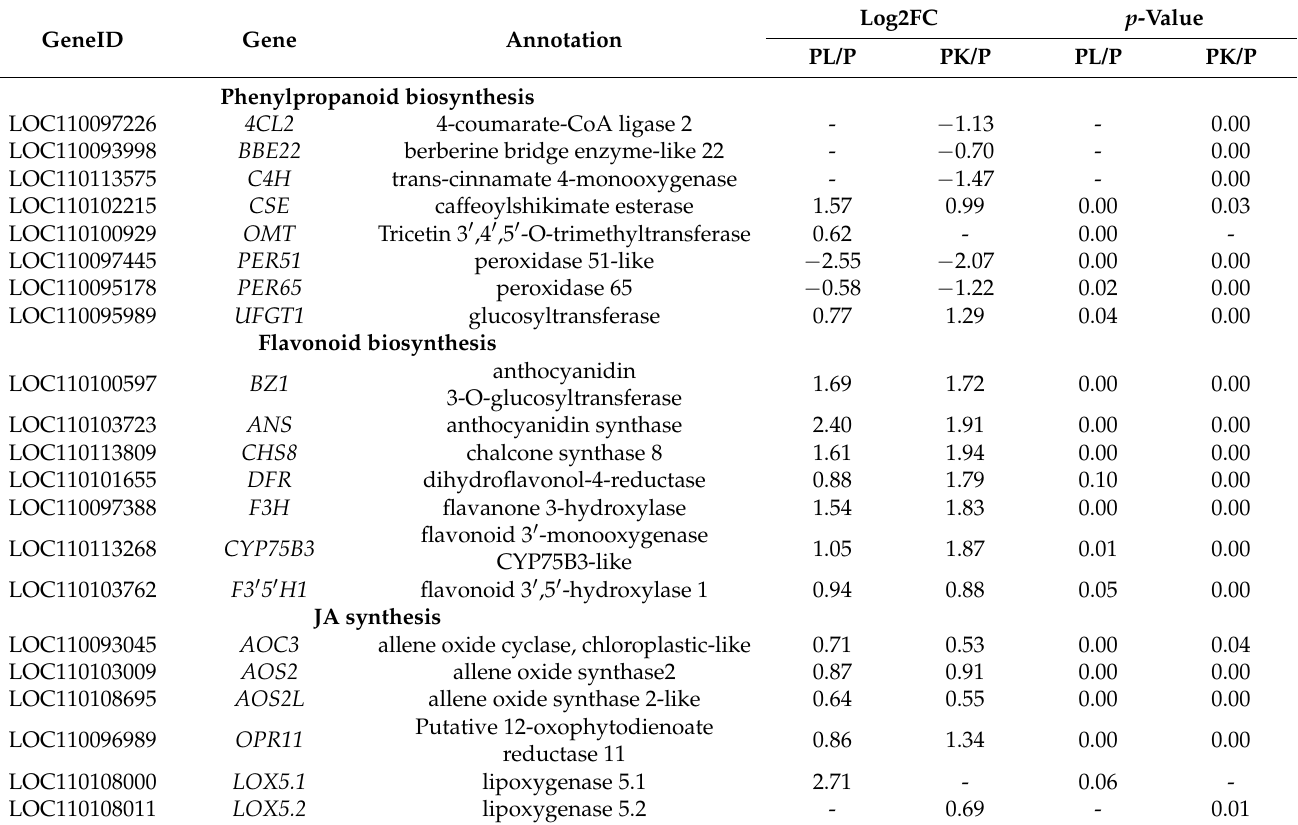
Table 2. The KEGG enrichment of DEGs in gene co-expressed